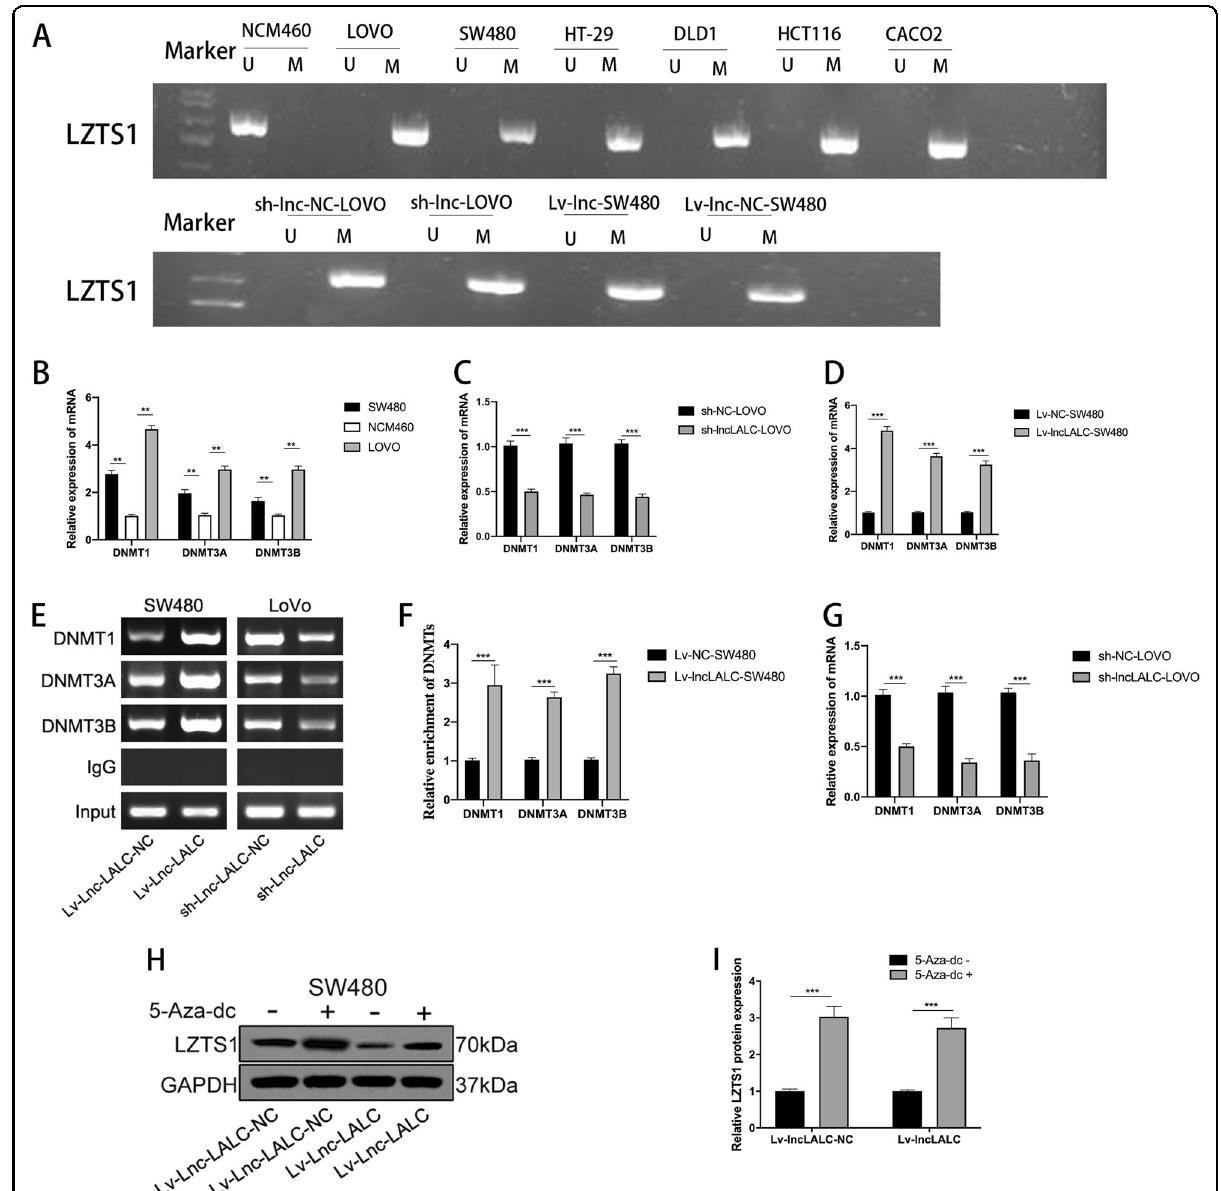
Fig. 5 Lnc-LALC regulated methylation of LZTS1 promoters via binding with DNA methyltransferases. A Methylation speci fi c PCR (MSP) revealed that the promoter region of LZTS1 was hypermethylated in CRC cells but hypomethylated in the NCM460 cells; and also revealed that the methylation level has a positive correlation with lnc-LALC expression level. U means unmethylated;M means methylated. B The expression level of DNMTs (DNMT1, DNMT3A, DNMT3B) was detected by qRT-PCR in SW480, LoVo cells, and NCM460 cells. C qRT-PCR assay showed knockdown of lncLALC could inhibit expression of DNMTs in LoVo cells. D qRT-PCR assay showed overexpression of lncLALC could promote the expression of DNMTs in SW480 cells. E – G ChIP assays revealed that the enrichment of DNMT1, DNMT3A, DNMT3B in LZTS1 promoter increased signi fi cantly after lncLALC overexpression in SW480 cells and reduced dramatically by lncLALC knockdown in LoVo cells. H , I Western blotting showed that methylation inhibition by 5-aza-2 ′ -deoxycytidine (5-Aza-dC) could restore LncLALC-induced LZTS1 suppression. * P < 0.05; ** P < 0.01; *** P <